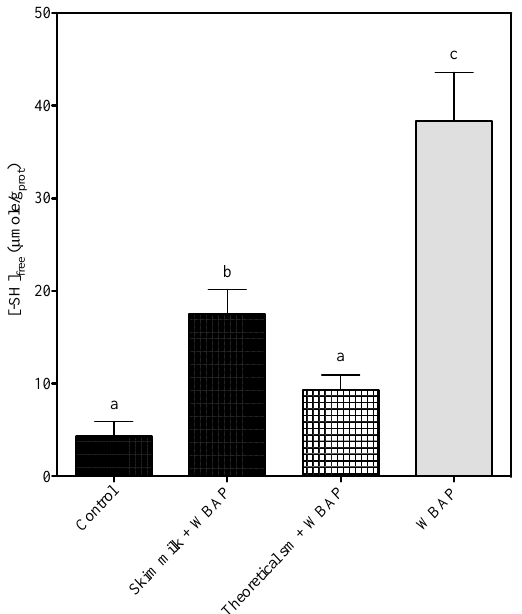
Figure 2. Effect of milk composition on thiol group exposure following heating (85 °C for 25 min, including ramp time); a Duncan post-test was applied to compare the means to the